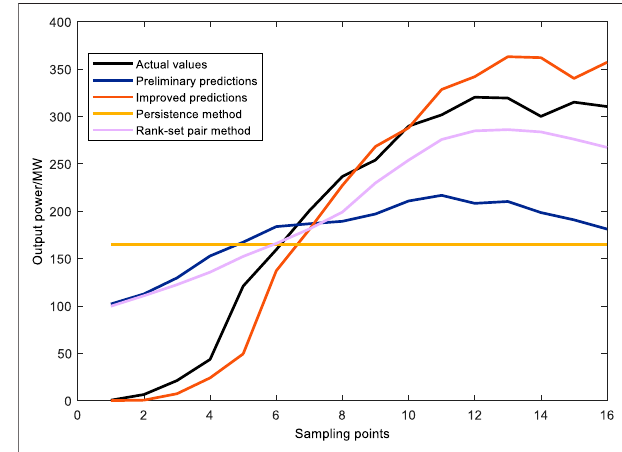
FIGURE 15 | Prediction accuracy at individual sampling points in the morning phase after improvement.